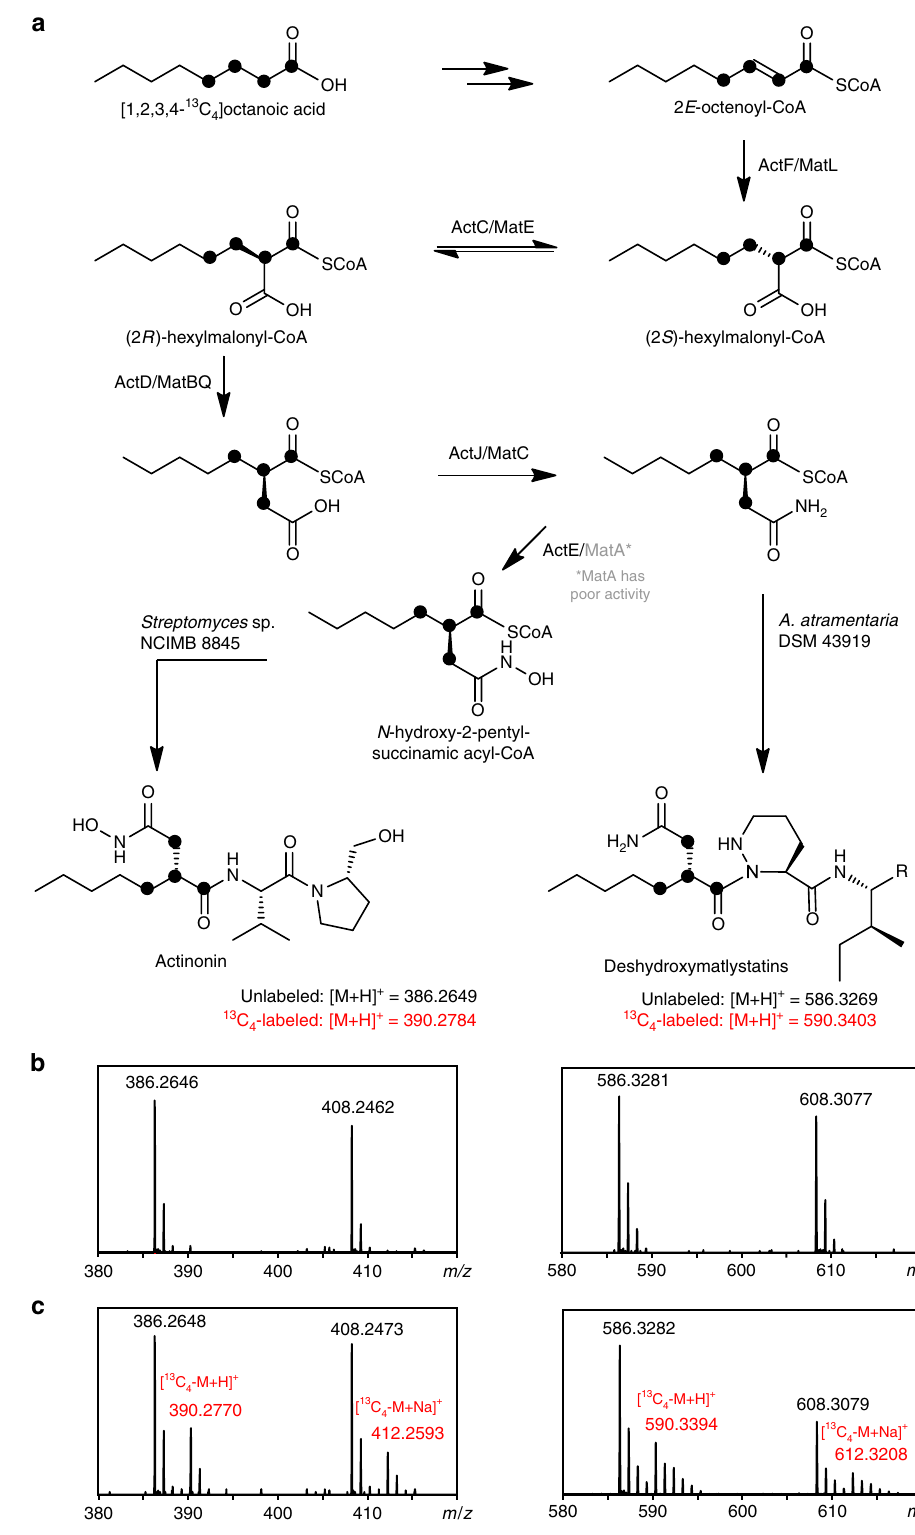
Fig. 6 Model for the biosynthesis of the actinonin and matlystatin hydroxamate warhead. a Pathway and proposed incorporation of [1,2,3,4- 13 C 4 ]-octanoic acid. b MS spectra of compounds from unlabeled media and c media fed with [1,2,3,4- 13 C 4 ]-octanoic